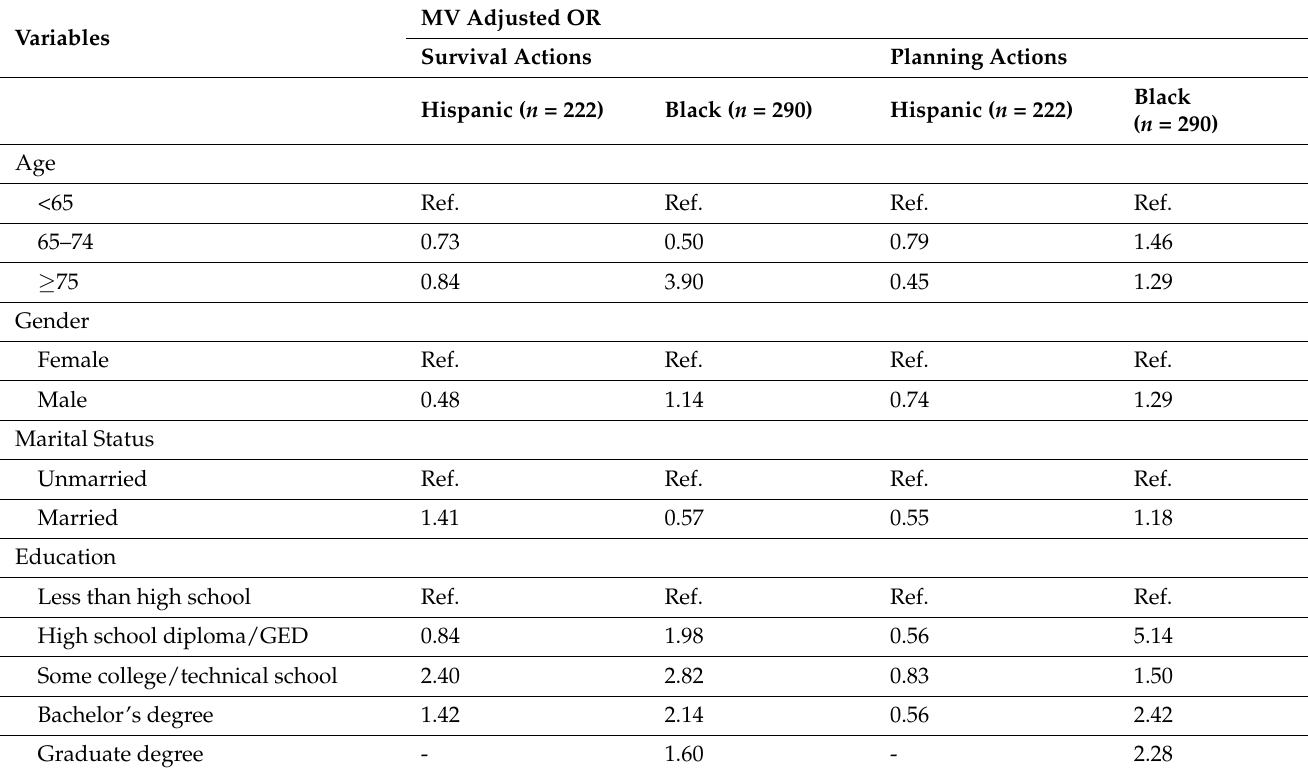
Table 3. Correlates of Survival and Planning Disaster Preparedness Actions among Hispanic and Black/African American